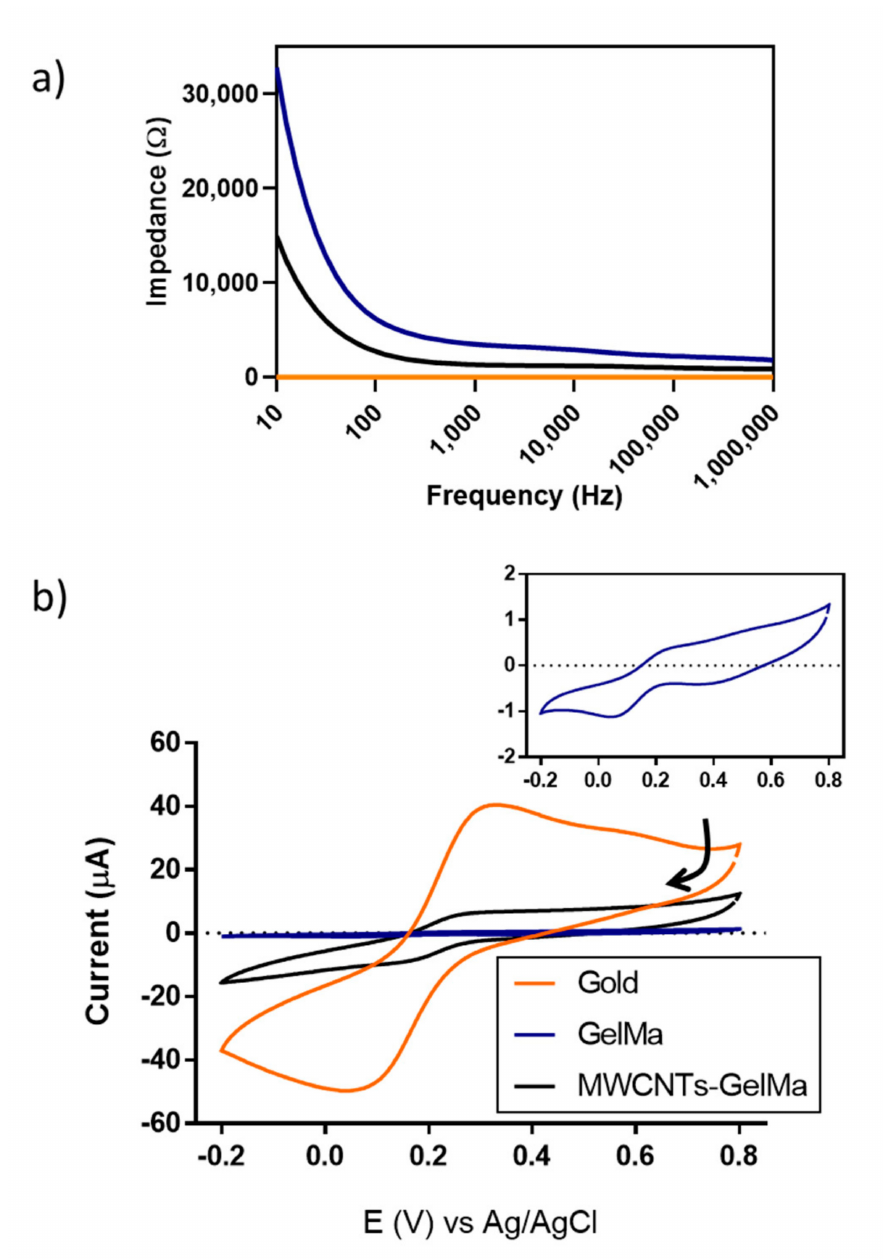
Figure 2. Electrochemical characterisation of gels. ( a ) Impedance spectroscopy measurements of GelMa and MWCNTs-GelMa (1 mg mL − 1 ) compared to gold surfaces. ( b ) Typical cyclic voltammo- grams (CVs) of gels developed in situ on gold surfaces. Potassium hexacyanoferrate (II) (1 mM) in phosphate buffer saline (PBS) was used as an electrolyte. CVs were measured from 0.8 to − 0.2 at 100 mV s − 1 vs. an Ag/AgCl reference electrode. Arrow indicates the direction of the CV. All mea- surements were performed in triplicate. Inset CV corresponds to GelMa, shown for